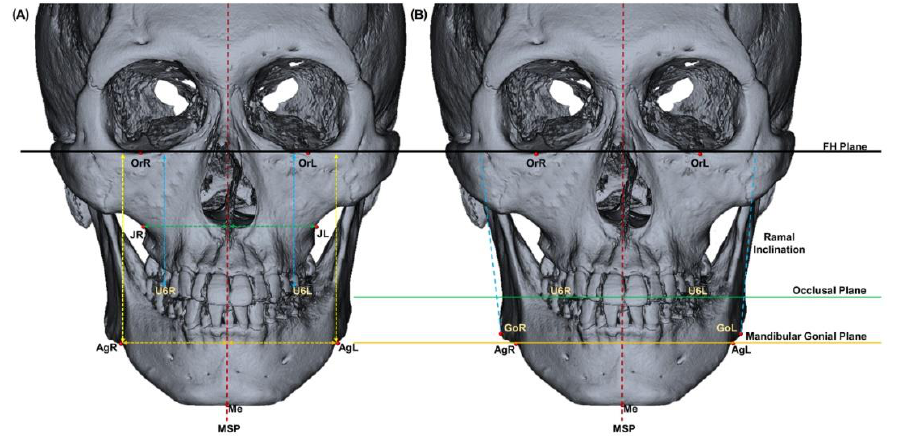
Figure 1. Schematic representation of the 3D image of symmetry analysis. ( A ) The absolute distance differences were calculated as the distance differences between the right and left sides in millimeters and ( B ) the angular difference between the planes in degrees (Table 1).